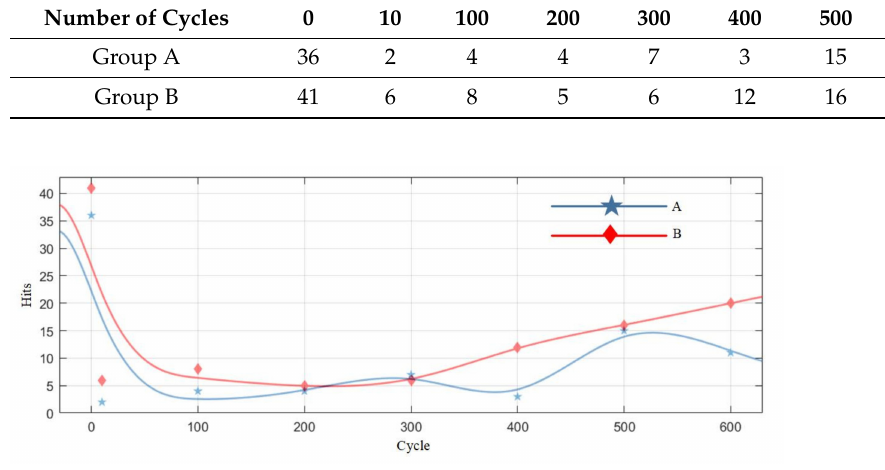
Figure 12. The variation curve of the number of pulse type acoustic emission